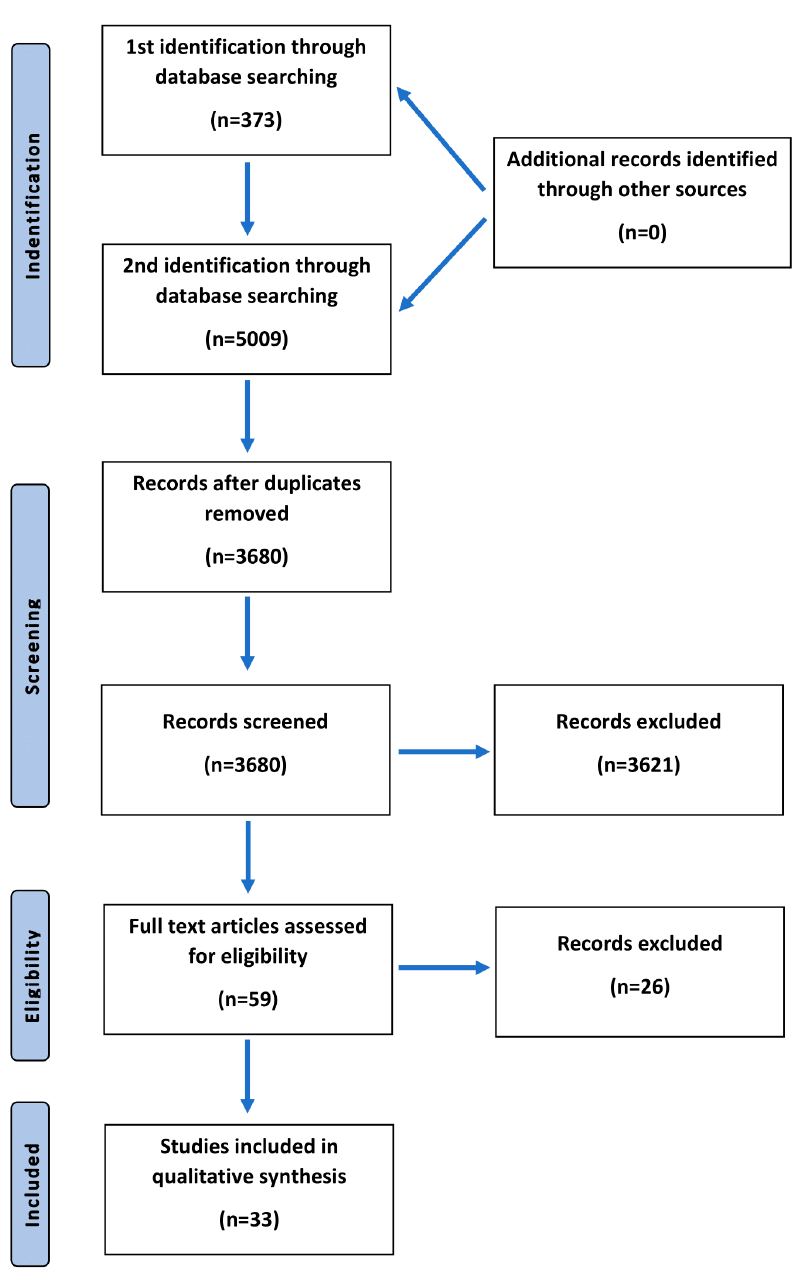
Figure 1. Flowchart presenting the process of article selection, according to Preferred Reporting Items for Systematic Review and Meta-Analyses (PRISMA) guidelines.